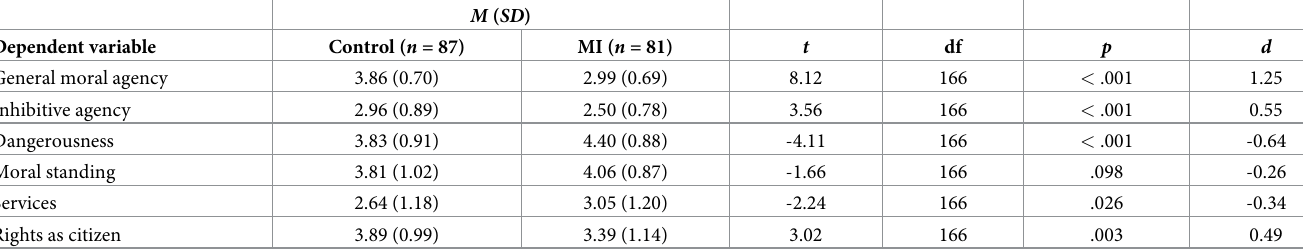
Table 3. Descriptive and t-test statistics for dependent variables after release (Study 1).